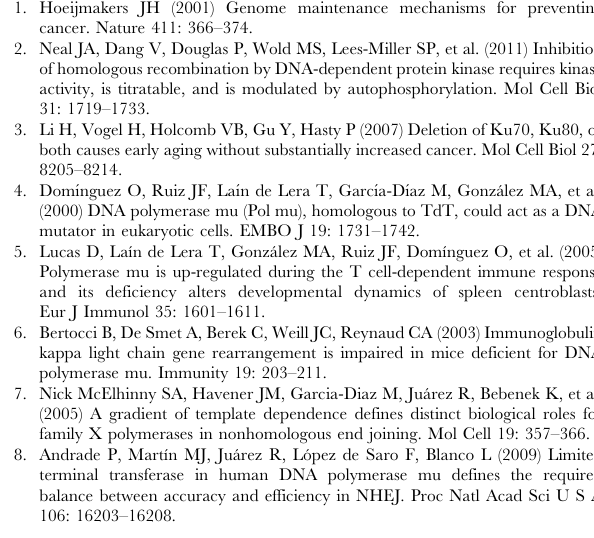
Figure S4 Evaluation of bone marrow genetic stability in Pol m 2 / 2 mice.